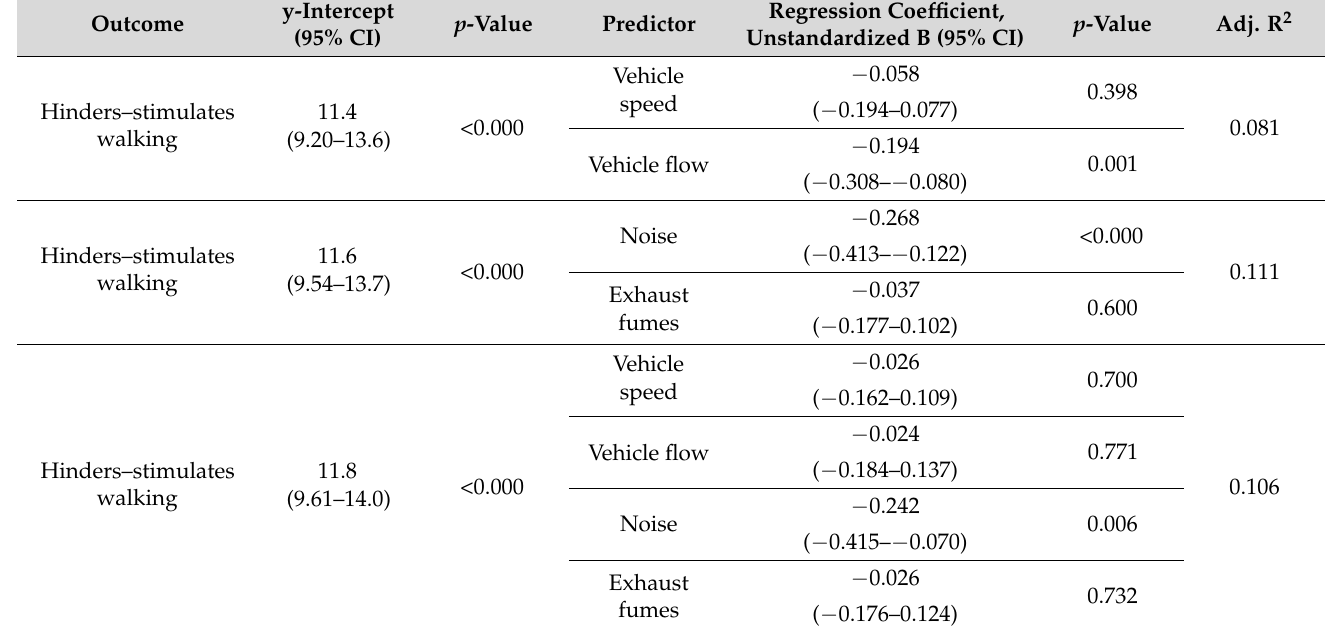
Table 7. Relations between combinations of predictor variables and the outcome hinders–stimulates walking .